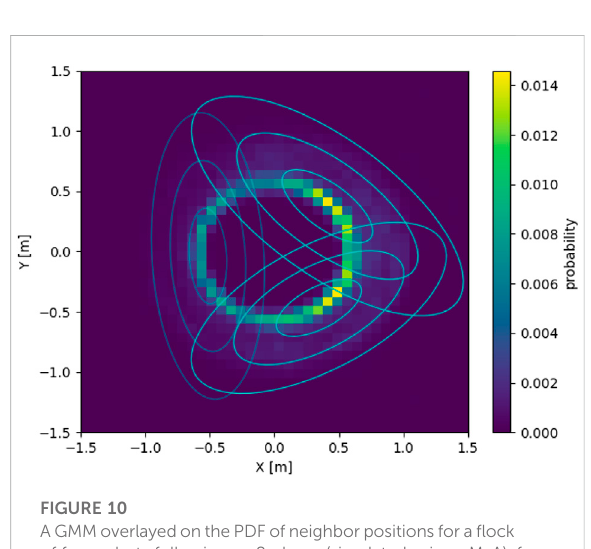
FIGURE 10 AGMMoverlayedonthePDFofneighborpositionsfora fl ock of four robots following an 8-shape (simulated using μ M-A), from the point of view of a robot placed at (0,0) facing